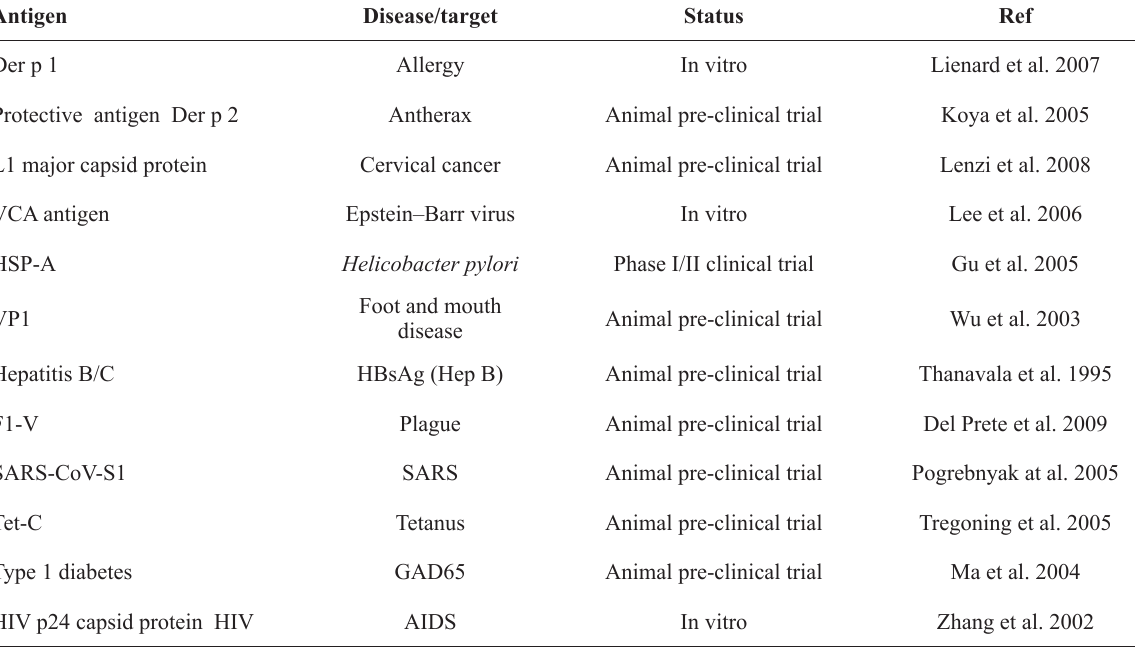
Examples of transiently expressed antigens using the Magnifection TM system. Antigen